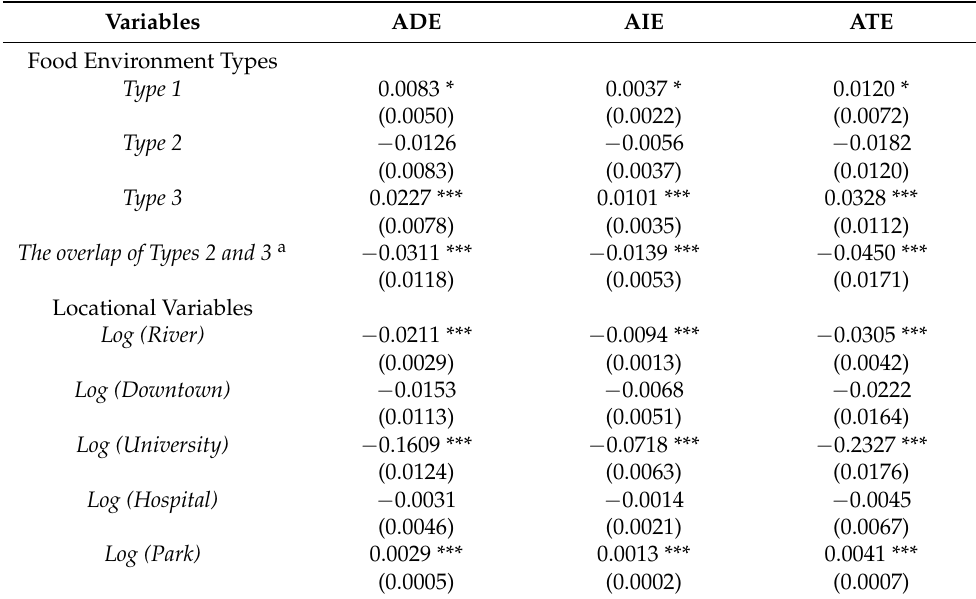
Table 4. Marginal Effects for Spatial Lag Model Based on Nearest 10